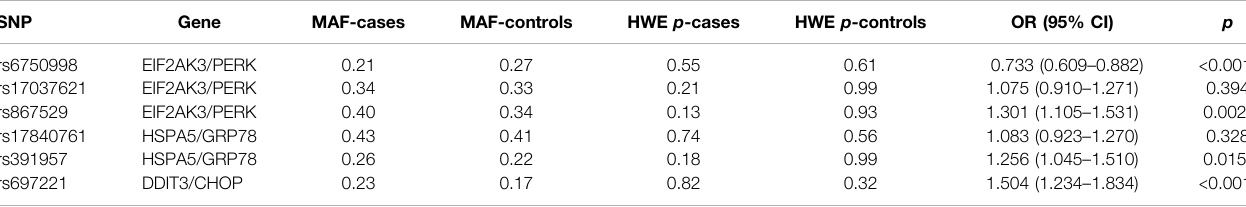
TABLE 3 | The MAF and HWE of candidate SNPs between lung cancer cases and healthy